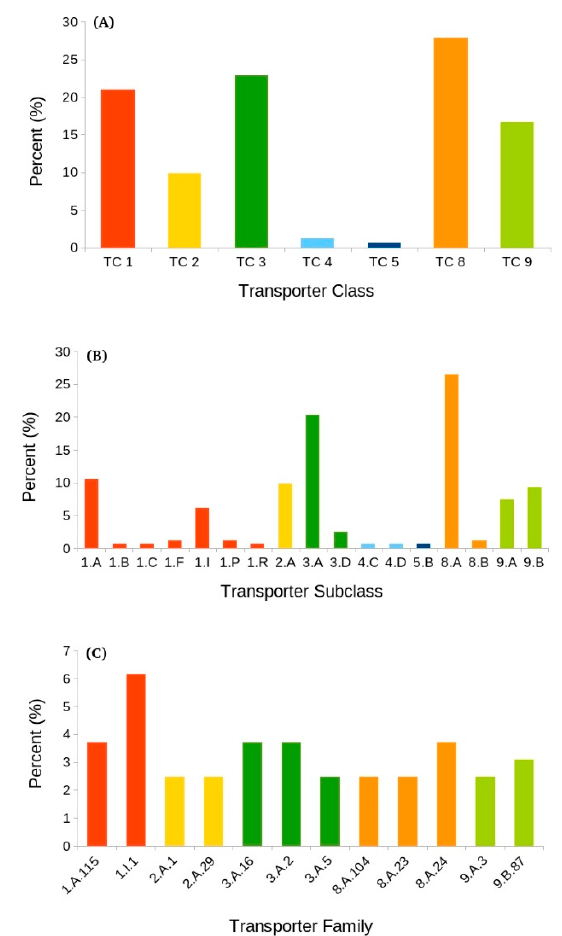
Figure 6. Classification of differentially expressed transcripts into various types of transporters at the ( A ) class, ( B ) subclass, and ( C ) family levels, as described in the Transporter Classification Database (TCDB) system.